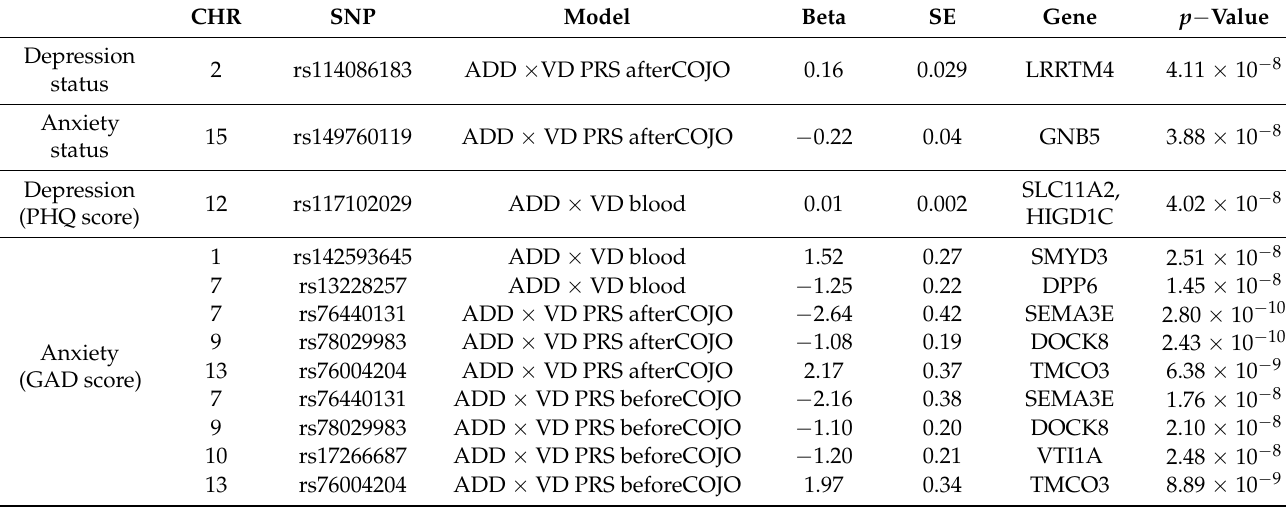
Figure 3. Genomic regions interacting with VD PRS before COJO adjustment for GAD score. This graph shows 7 independent SNP alleles interacting significantly with blood VD in anxiety disorders (GAD score). From the center, the first circos depicts the − log10 p -values of each variant due to double exposure, i.e., the effect of both SNP allele and VD PRS before COJO adjustment. The second circos shows chromosome density. Red dots represent the p < 5 × 10 − 8 and green dots represent p < 1 × 10 − 7 . The figure was generated using the “CMplot” R script (https://github.com/YinLiLin/R-CMplot) (accessed on 15 February 2021). Table 3. Summary of gene − environment interaction analysis among SNP and VD traits for depression and anxiety